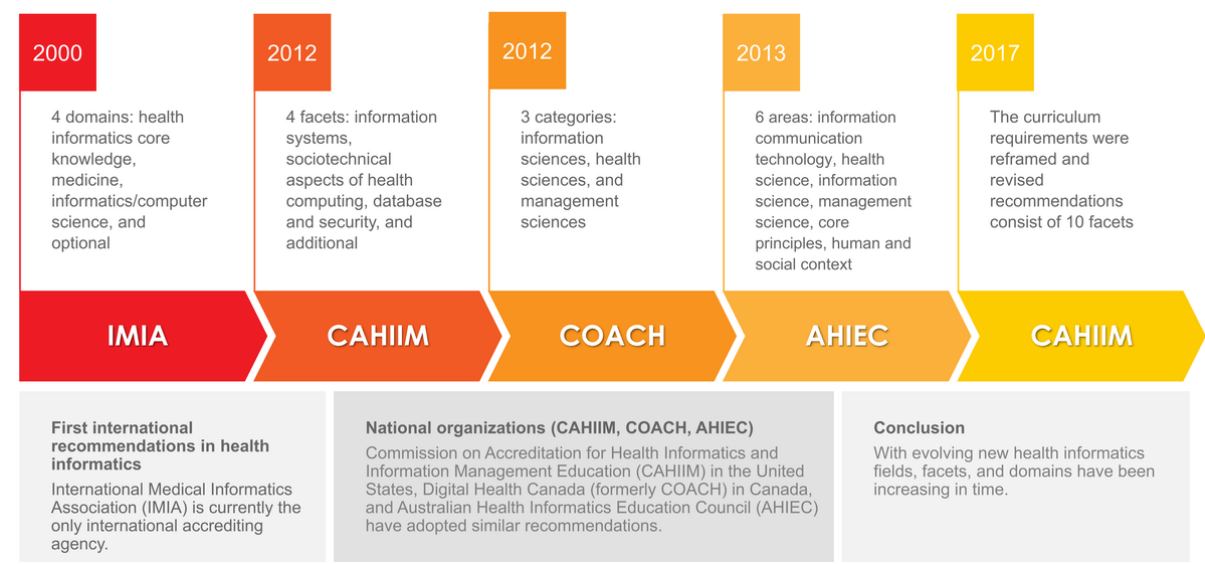
Figure 3. Evolving health informatics curriculum competencies. AHIEC: Australian Health Informatics Education Council; CAHIIM: Commission on Accreditation for Health Informatics and Information Management Education; IMIA: International Medical Informatics